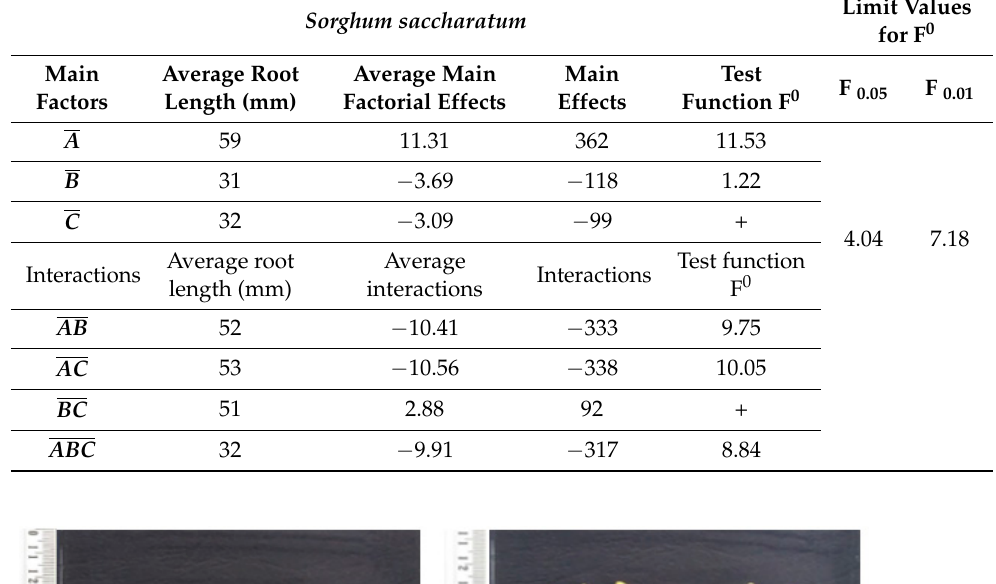
Table 12. Mean main factorial effects, average interactions, and their significance for Sorghum saccharatum .